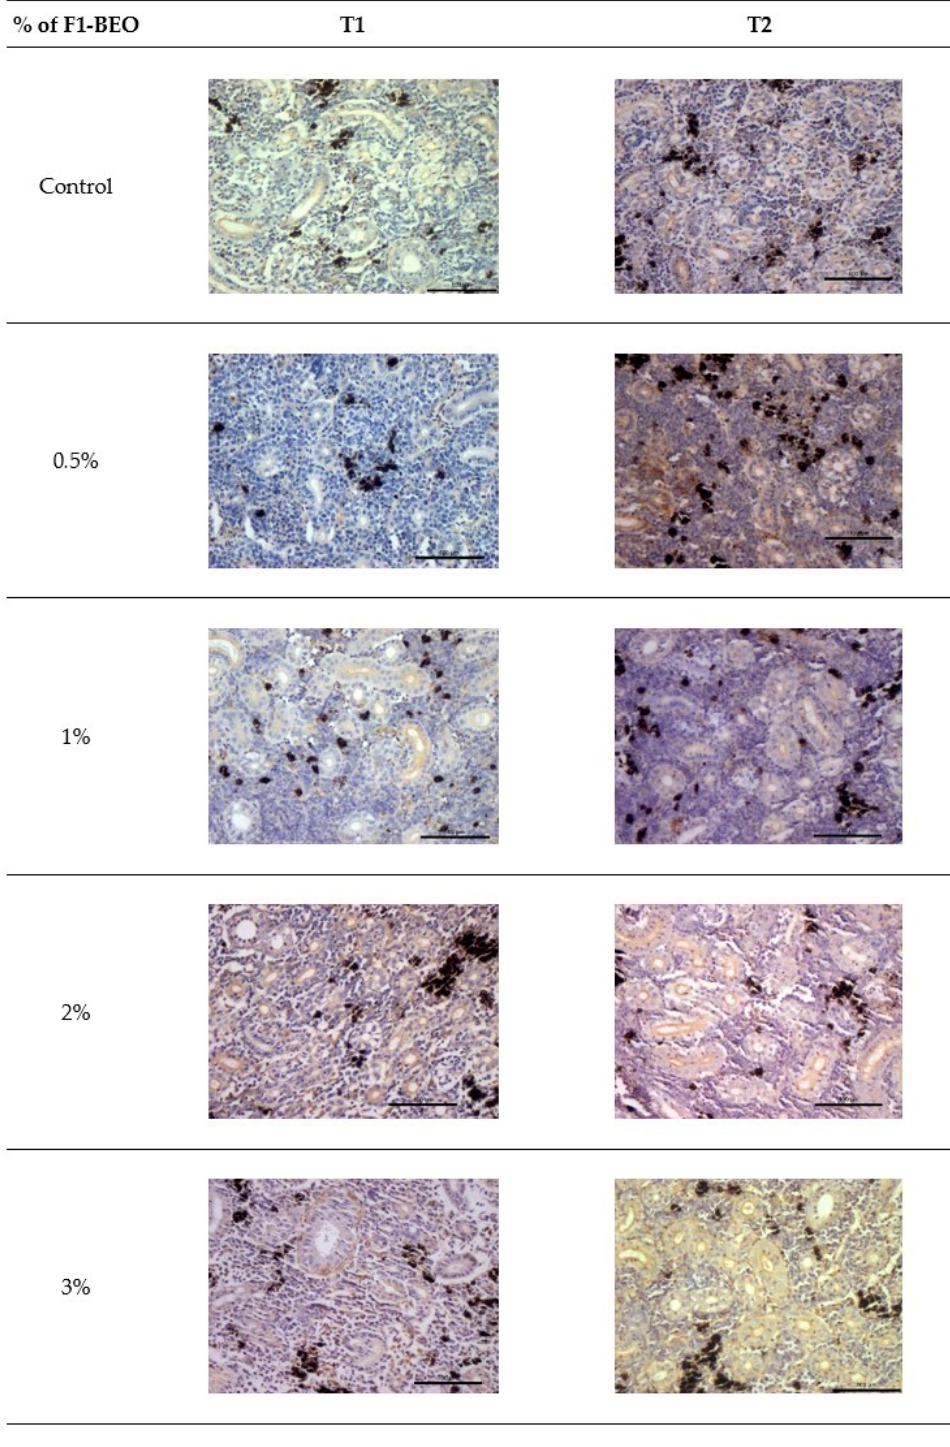
Figure 7. Immunohistochemistry assays to identify TRPV1 receptor in kidney specimens. The positivity is comprehensible due to the brownish color. T1 = 15 days. T2 = 30 days. Magnification: 20×.